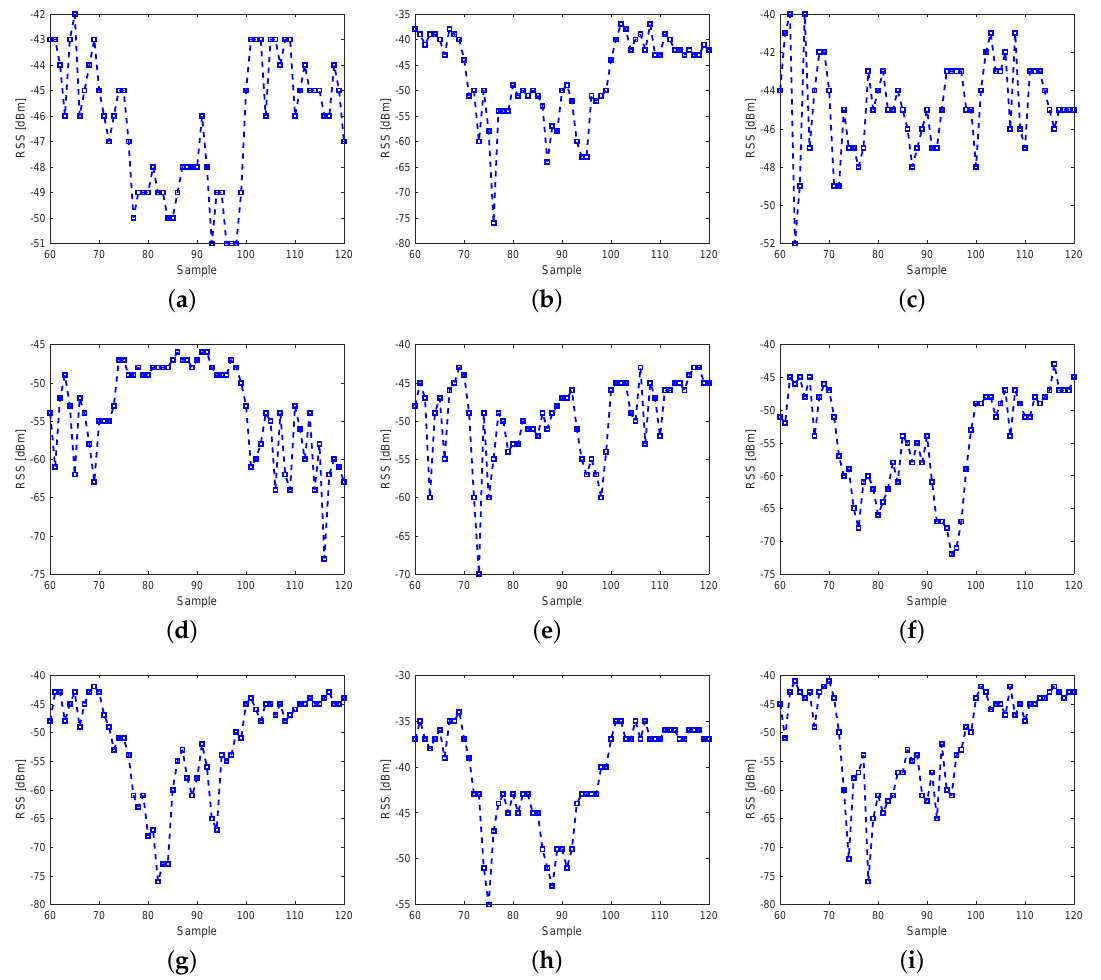
Figure 2. Temporal variation of RSS measured on nine sublinks of the link between node 6 and node 9 with human movement. ( a ) sublink #1; ( b ) sublink #2; ( c ) sublink #3; ( d ) sublink #4; ( e ) sublink #5; ( f ) sublink #6; ( g ) sublink #7; ( h ) sublink #8; ( i ) sublink